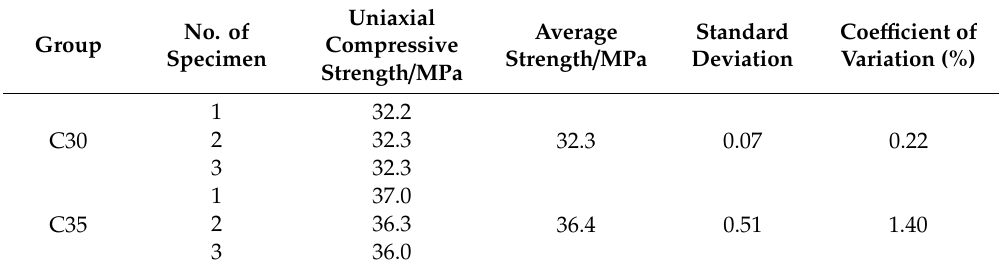
Table 1. Cubic compressive strength for C30 and